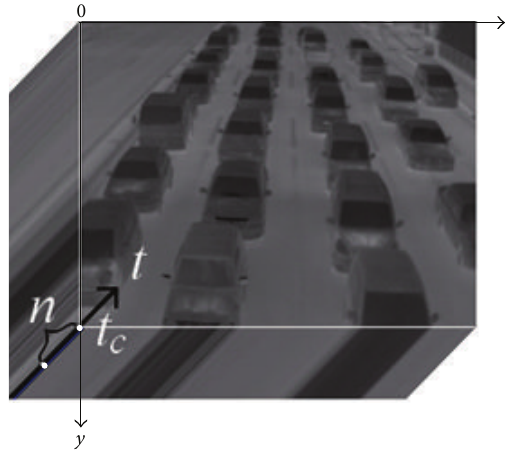
Figure 3: An example of spatiotemporal images.